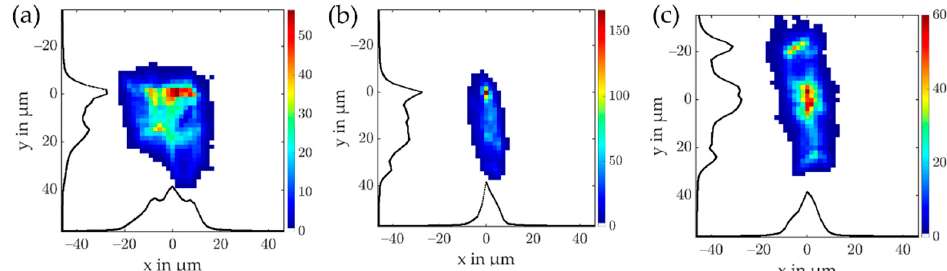
Figure 4. Profiles of the XUV beam in Zr window in and around the focus position with fully open iris. ( a ) XUV beam profile 1 mm in front of the focus. ( b ) XUV beam profile at the focal plane. ( c ) XUV beam profile 1 mm behind the focus. A total of 300 single-shot images were averaged for each figure. The alignment of the ellipsoidal mirror was performed in a way that the peak intensity at the focal plane was maximized. The black lines indicate the horizontal and vertical projections of the corresponding 2D image. The x and y FWHM spot sizes of the projections in the focus were 7 × 26 µm.